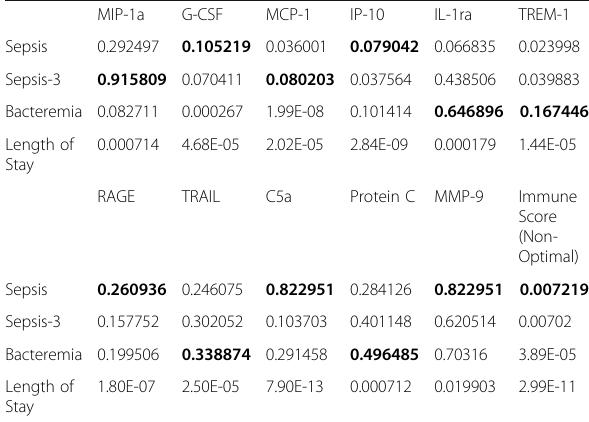
Table 4 (abstract P42). See text for description